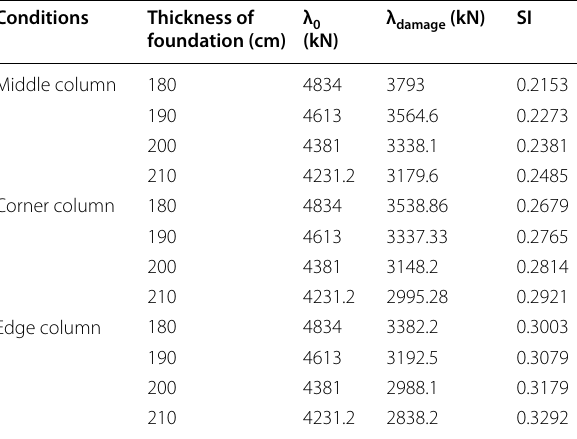
Table 6 Redistribution of the imposed loads in the 20-story RC frames with different thicknesses of foundation in FLAC